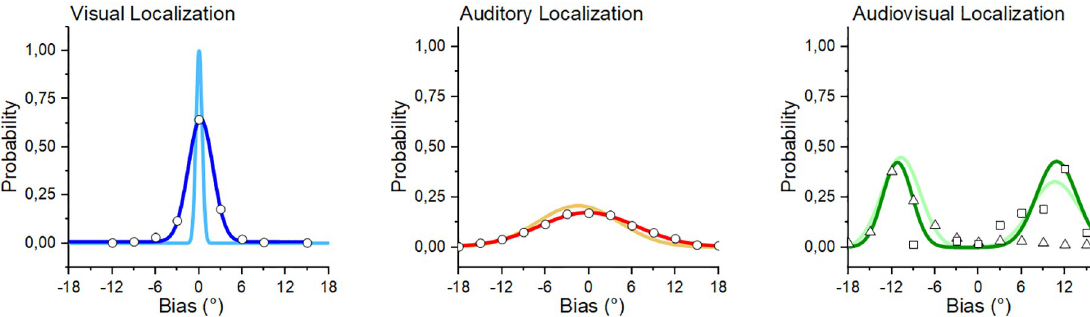
Fig 4. Gaussian fit for all three localization tasks. Darker colors represent the averaged human observer performance, while lighter colors represent the performance of the neural architecture. From the visual (A) and auditory (B) Gaussian fits, we extracted the X a , X v , σ v , and σ a parameters that were successively used to model performance in the audio-visual (C) task. Scatter points indicate raw data for human participants (in Panel C, open triangles and open squares indicate performance in the visual-left and visual-right condition, respectively).